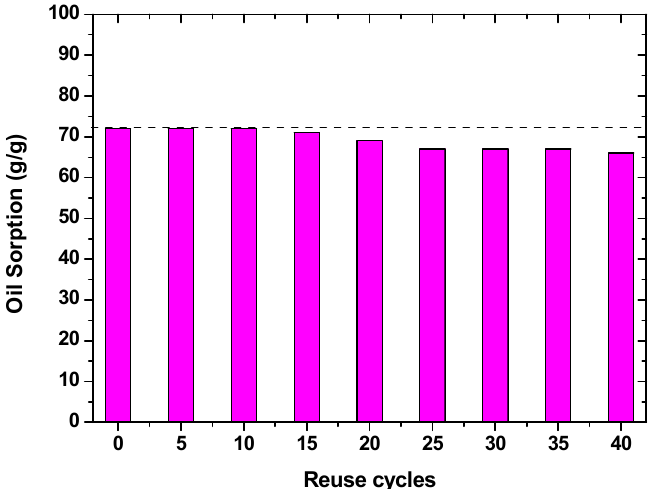
Figure 7. Reuse ability of ACp-600 after up to 40 cycles of use.